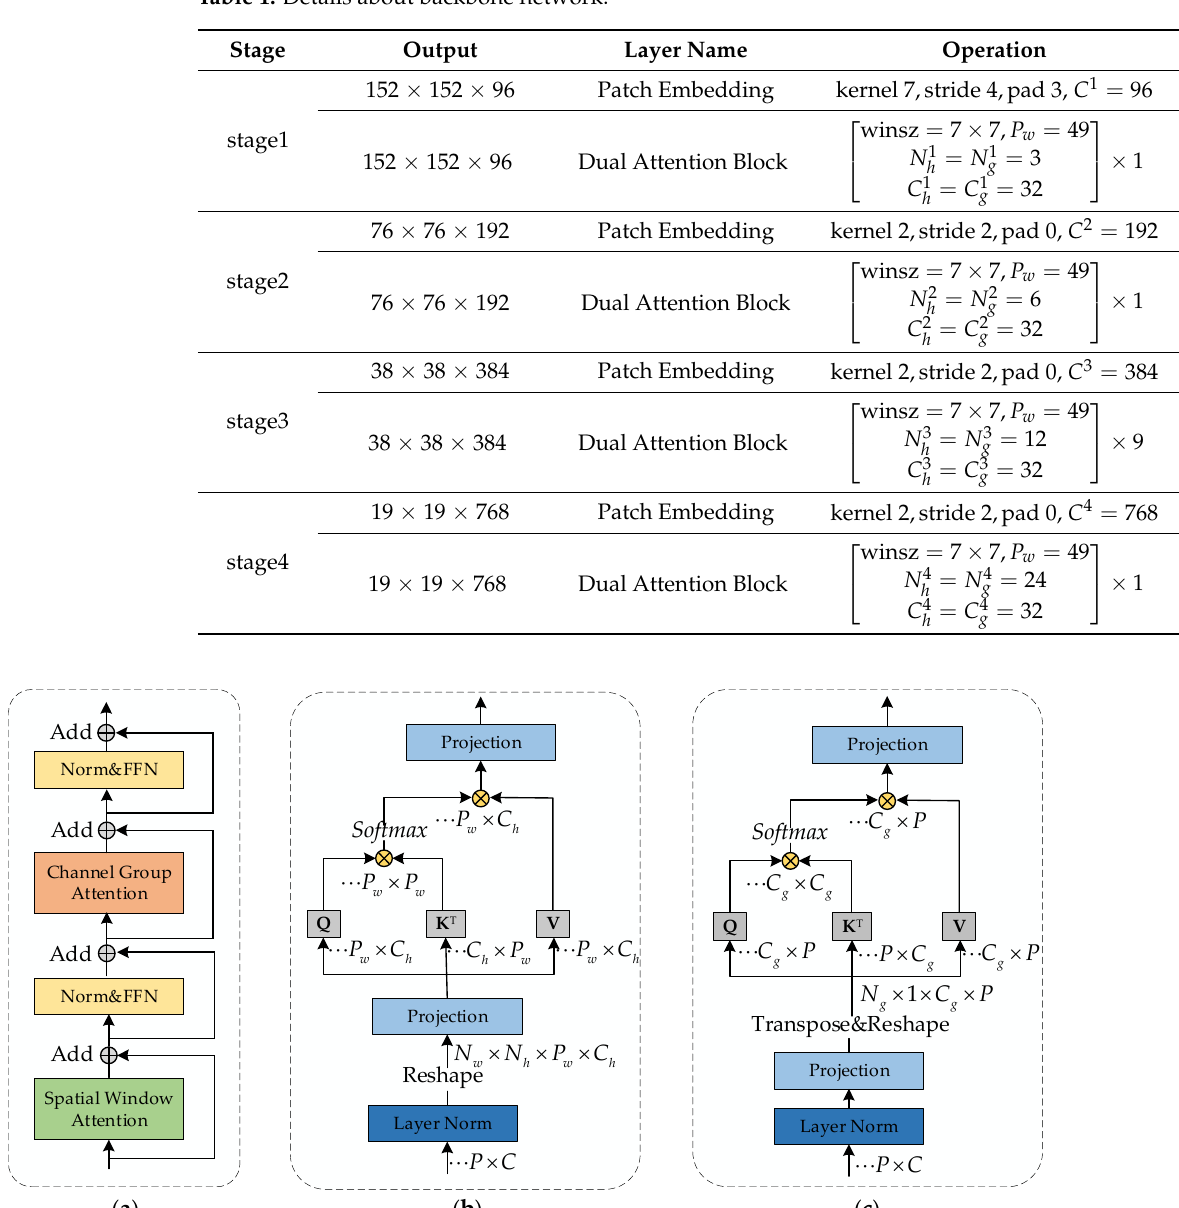
Figure 2. The network structure of the dual attention block is mainly made up of the channel group attention block and spatial window multi-head attention block: ( a ) dual attention block; ( b ) spatial window multi-head attention block; ( c ) channel group attention block. P represents the number of total patches, C devotes the number of total channels, N w is the number of windows, N h represents the number of heads, N g is the number of channel groups, P w devotes patches per window, C h is channels per head, and C g represents channels per